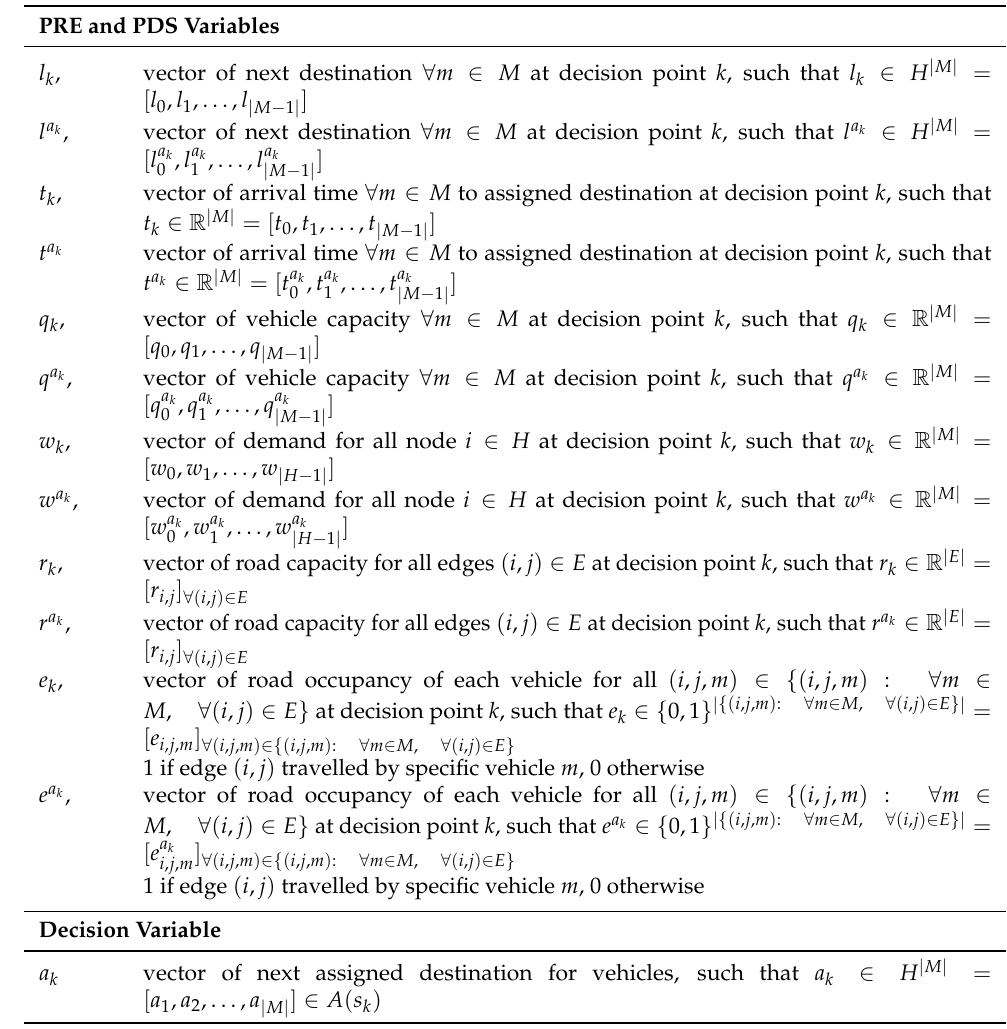
Table 2. MDDVRPSRC: State and Decision